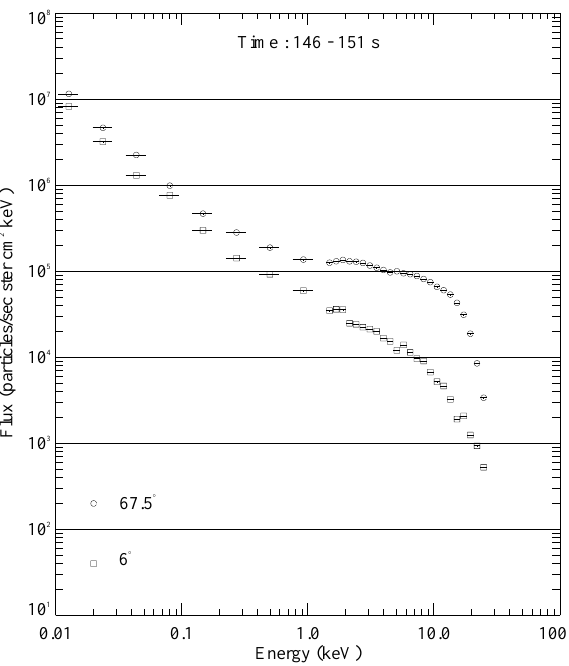
Fig. 3. Energy spectra for electrons at 0 ◦ –11 ◦ (circles) and 62 ◦ –73 ◦ (squares) pitch angle electrons for the pulsation starting at 146s.